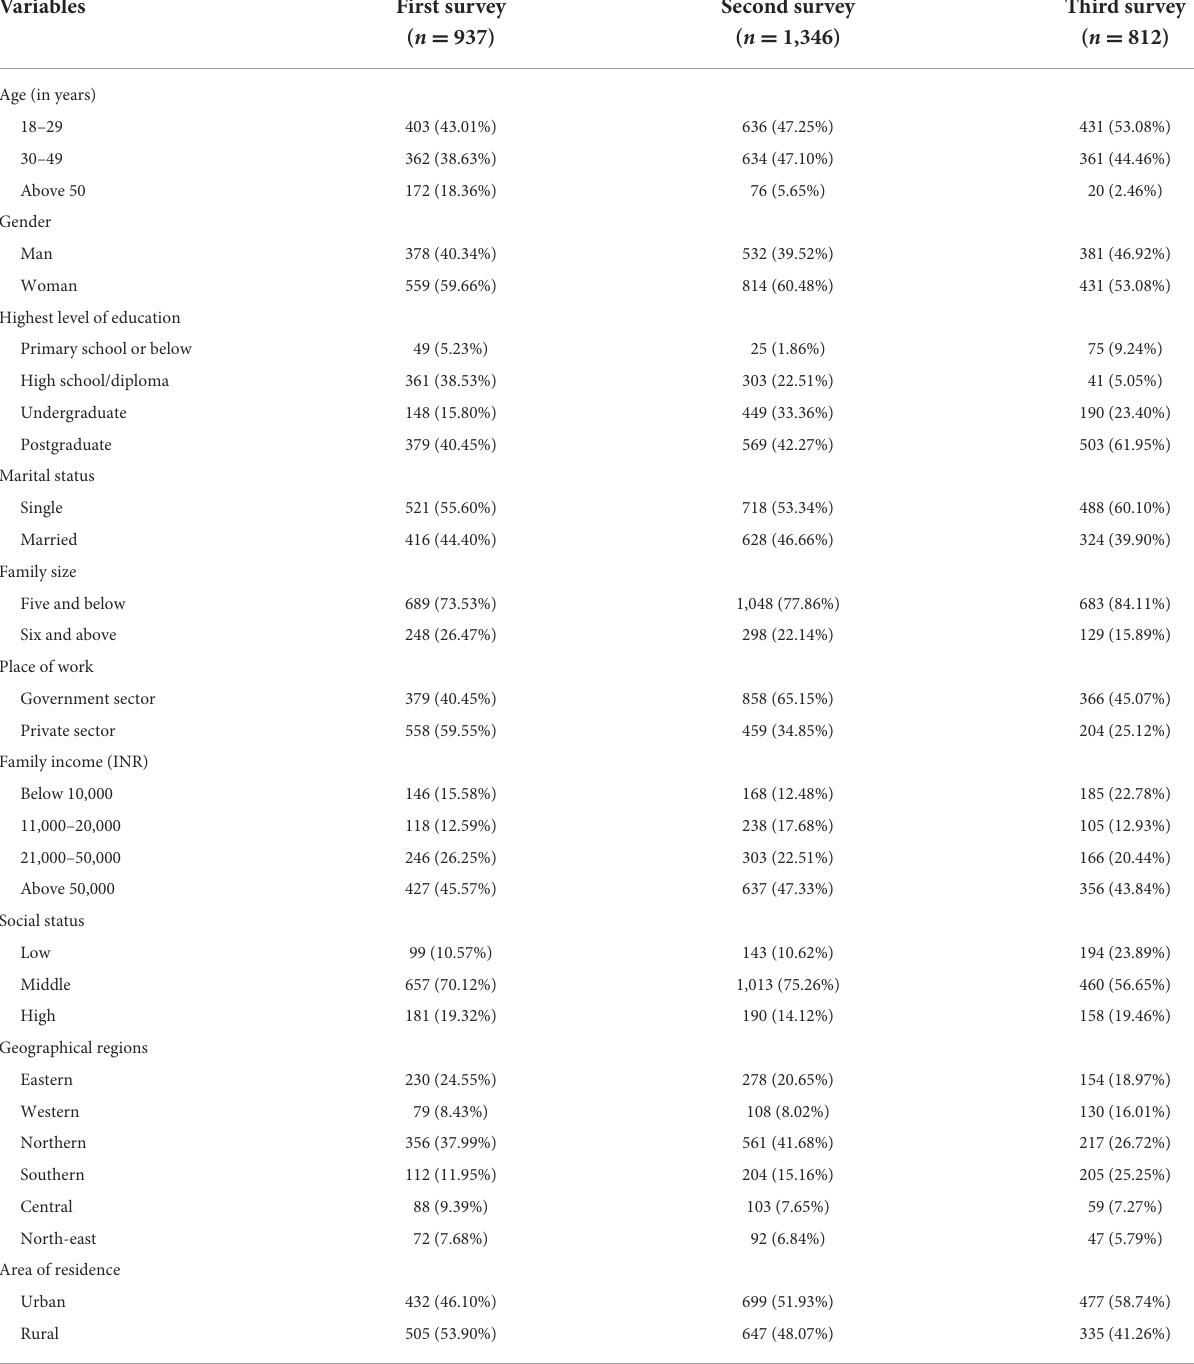
TABLE 1 Socio-demographic characteristics of the study